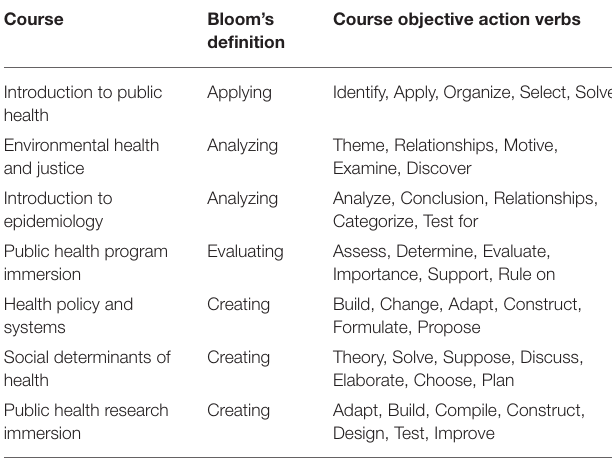
TABLE 2 | Public health course with Bloom’s Taxonomy revised categorical definition and action